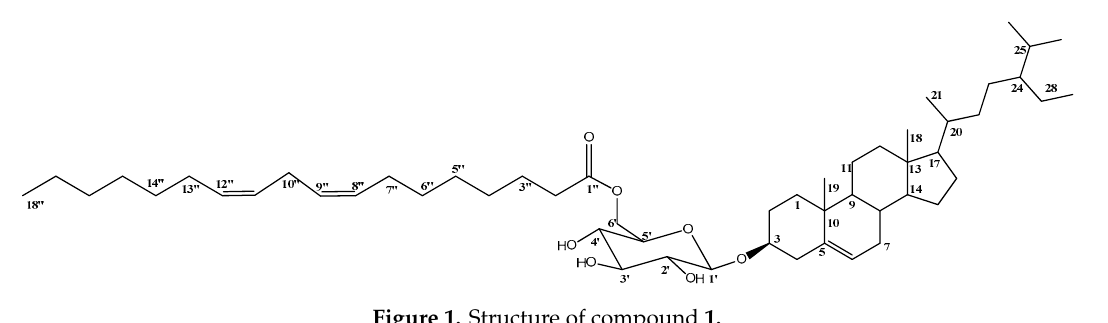
Figure 1. Structure of compound 1. Table 1. NMR spectroscopic data of 1 (C 5 D 5 N, 500 and 125